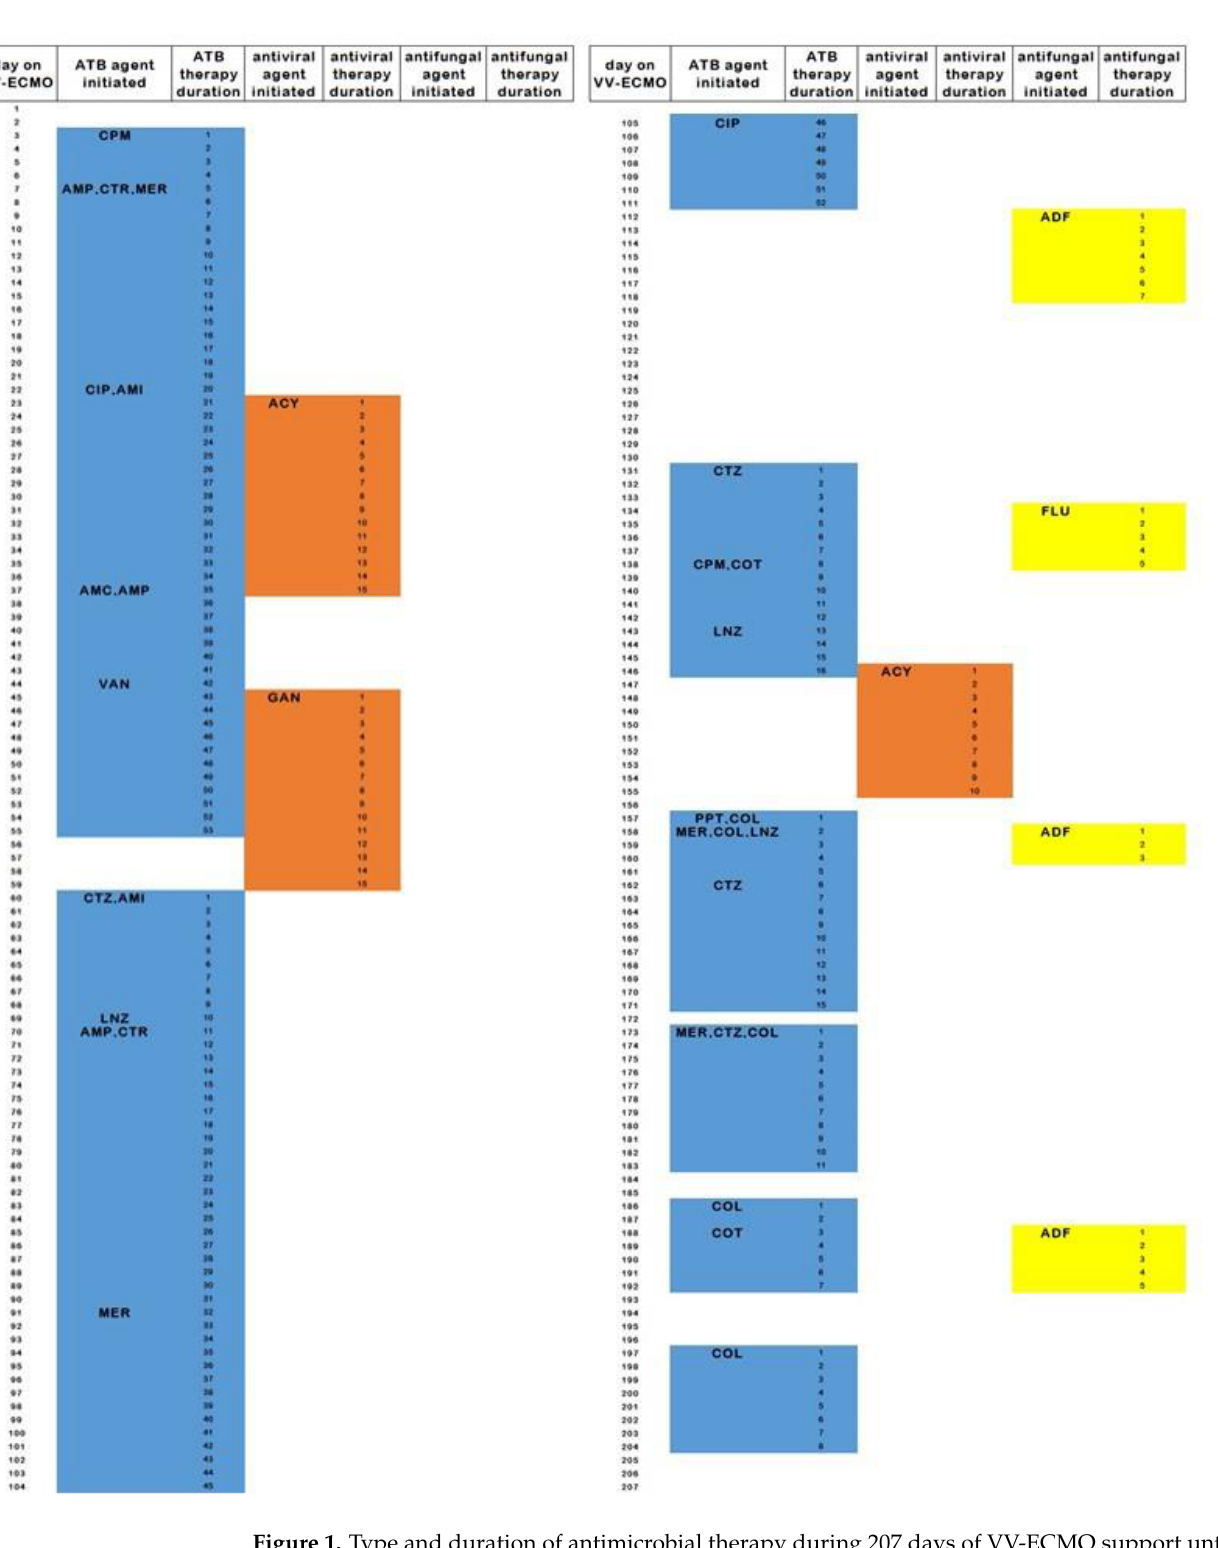
Figure 1. Type and duration of antimicrobial therapy during 207 days of VV-ECMO support until lung transplantation. Antibiotic therapy is in blue, antiviral therapy in orange and antifungal therapy in yellow. ACY = aciclovir, ADF = anidulafungin, AMC = amoxicillin + clavulanic acid, AMP = ampicillin, ATB = antibiotic, CIP = ciprofloxacin, COL = colistin, COT = co-trimoxazole, CPM = cefepime, CTR = ceftriaxone, CTZ = ceftazidime, FLU = fluconazole, GAN = ganciclovir, LNZ = linezolide, MER = meropenem, PPT = piperacillin/tazobactam, VAN =